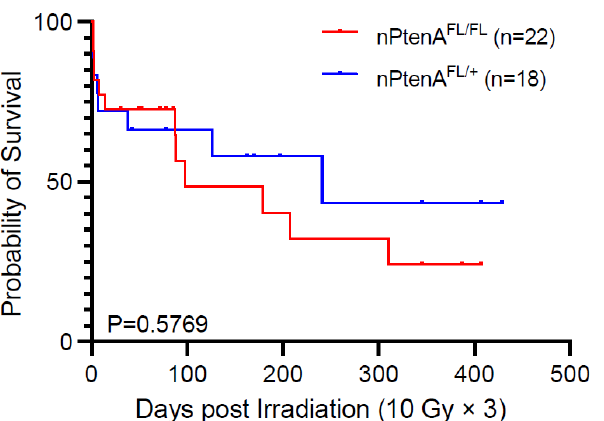
Figure 4. Effect of ATM loss in tumor cells on survival of mice bearing Pten -null brainstem gliomas after irradiation. Survival of nPtenA FL/FL mice with tumors lacking ATM following 10 Gy × 3 of focal brain irradiation is compared to littermate control nPtenA FL/+ mice with tumors that retain ATM . p -value is for the log-rank